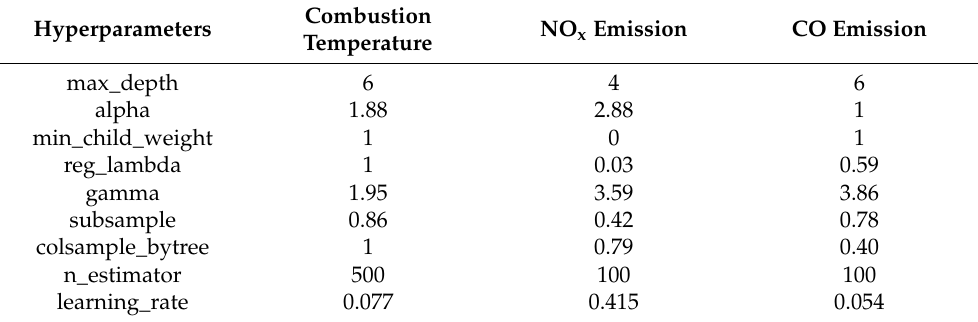
Table 1. Hyperparametes for the proposed XGBoost model.